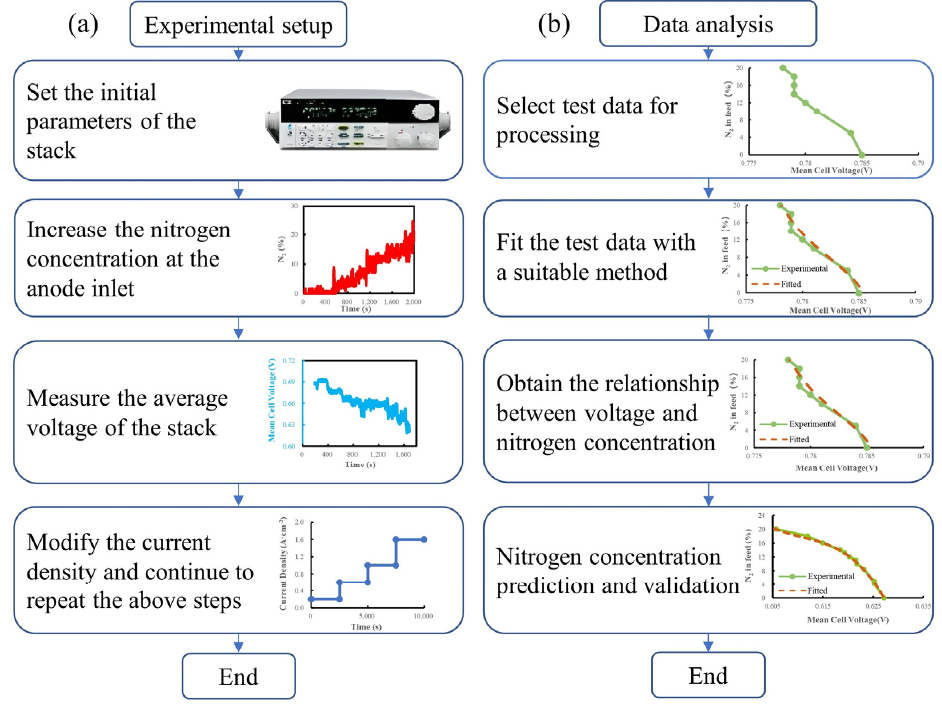
Figure 2. Flow chart of experiments and data processing: ( a ) Experimental procedure; ( b ) Data processing process.